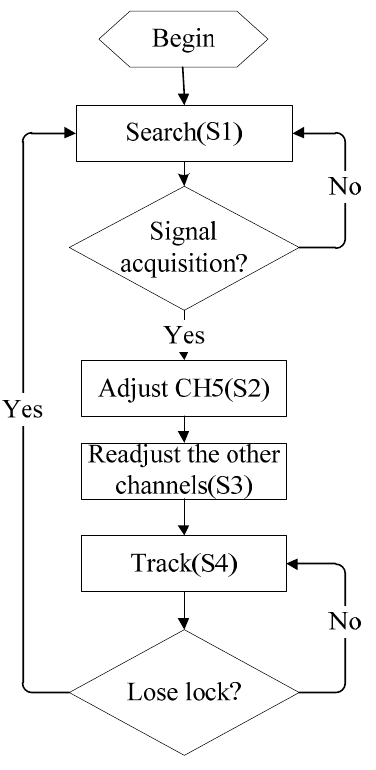
Figure 9. The work flow chart of the receive system.